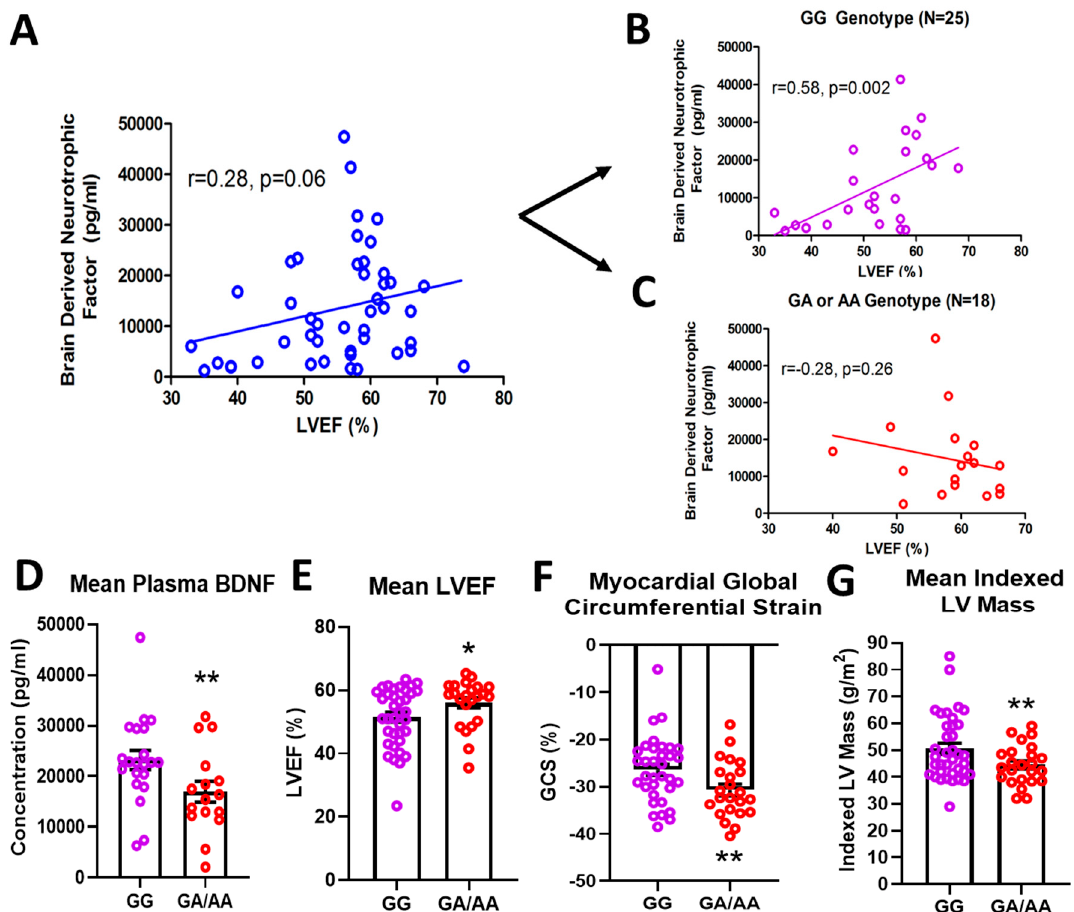
Figure 1. Effects of rs6265 polymorphism on cardiac phenotype. There is a disparate relationship between brain-derived neurotrophic factor (BDNF) levels and left ventricular ejection fraction (LVEF) for Duchenne muscular dystrophy (DMD) patients segregated by rs6265 polymorphism. ( A ) plot for the entire DMD subset cohort ( n = 43) demonstrating positive correlation of plasma BDNF concentration (pg / mL) vs. LVEF (%) by cardiac magnetic resonance (CMR) (r = 0.28, p = 0.06). When segregated by rs6265 polymorphism, a similar positive correlation (r = 0.58, p = 0.002) was seen for GG (Val / Val) DMD patients ( B ) but a negative correlation was observed (r = − 0.28, p = 0.26) for GA (Val / Met) and AA (Met / Met) DMD patients ( C ). GA / AA carriers had lower plasma levels of BDNF ( D ), higher mean LVEF ( n = 37 vs. 24) ( E ), better global circumferential strain (GCS) ( n = 37 vs. 24) ( F ), and lower indexed LV mass ( n = 37 vs. 24) ( G ). Comparisons by two-way ANOVA or Welch’s t-test. Asterisk represents statistical significance for GG versus GA / AA, * p < 0.05, ** p < 0.03. Individual patients (unsegregated) are indicated by blue circles. Purple circles indicate patients without (GG) the BDNF polymorphism. Rec circles denote those patients with one (GA) or both (AA) BDNF rs6265 alleles.